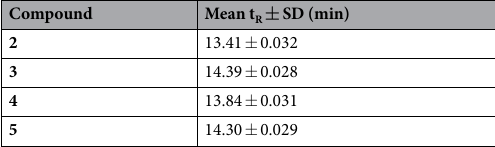
Table 4. Mean retention times of the synthesized